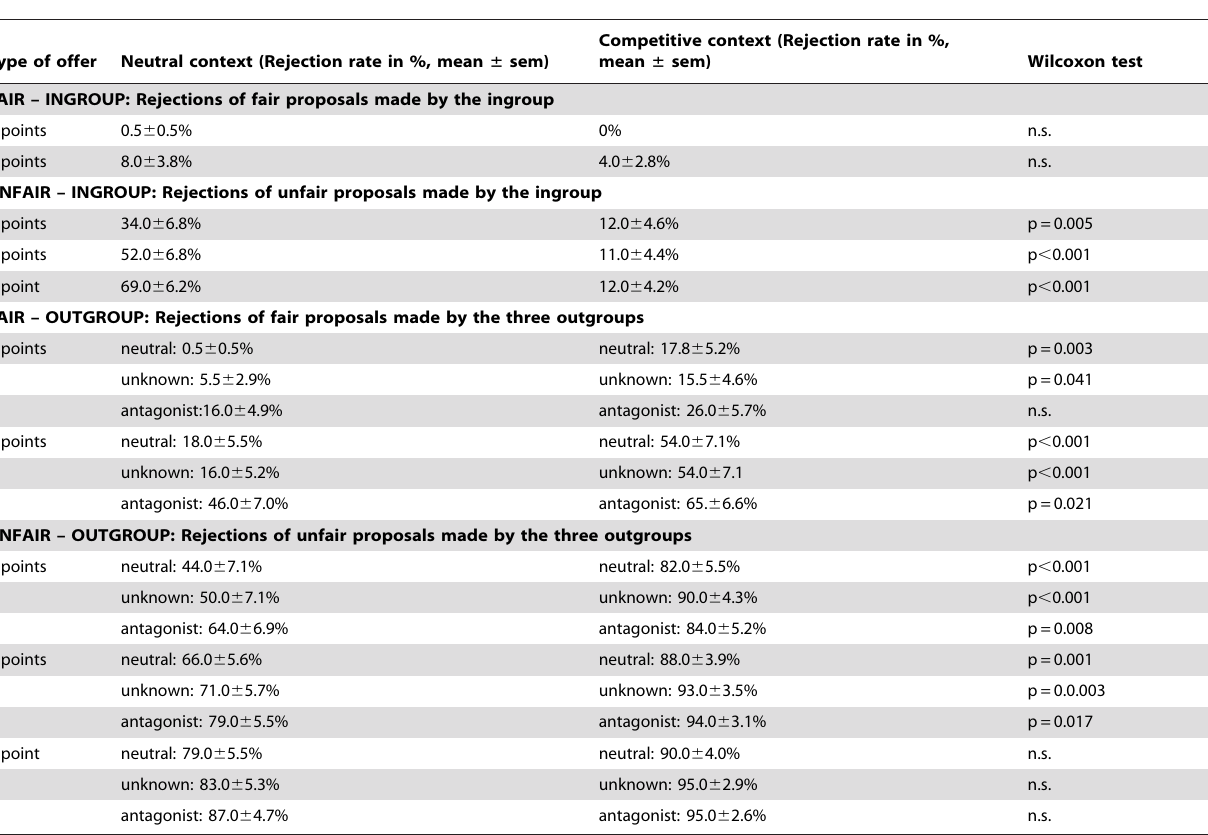
Table 1. Percentage of rejections in the neutral and in the competitive